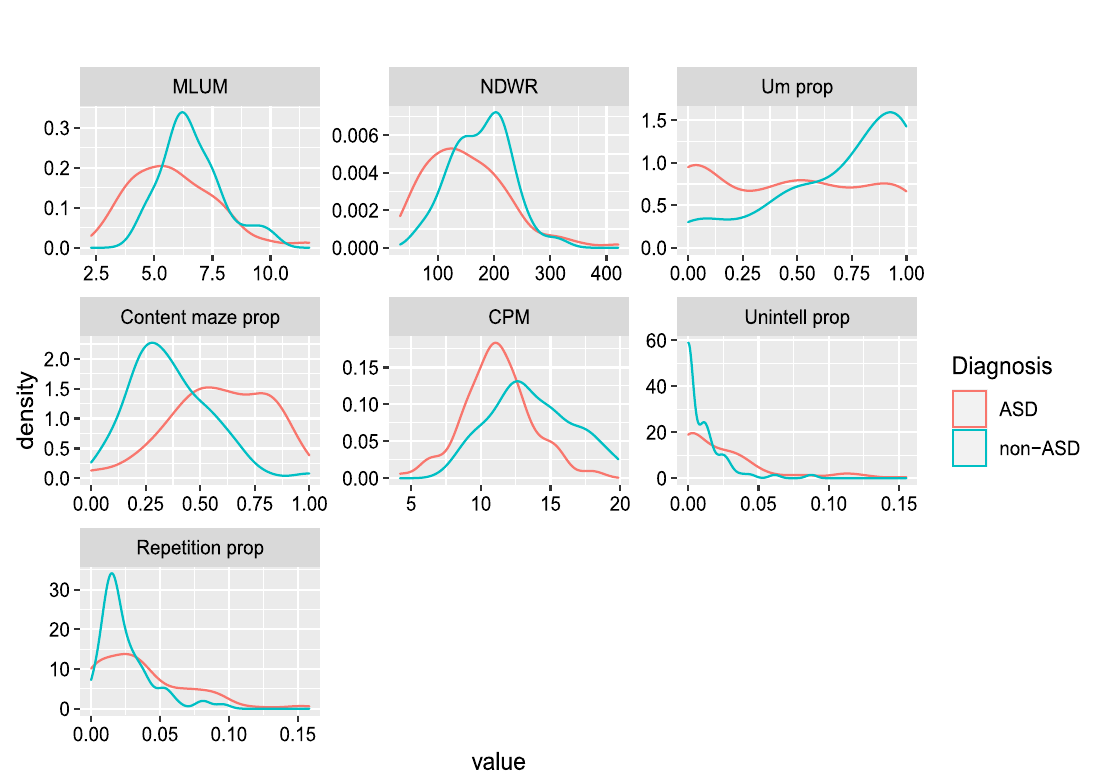
Figure 1. Relative frequency distribution of each ALM by ASD